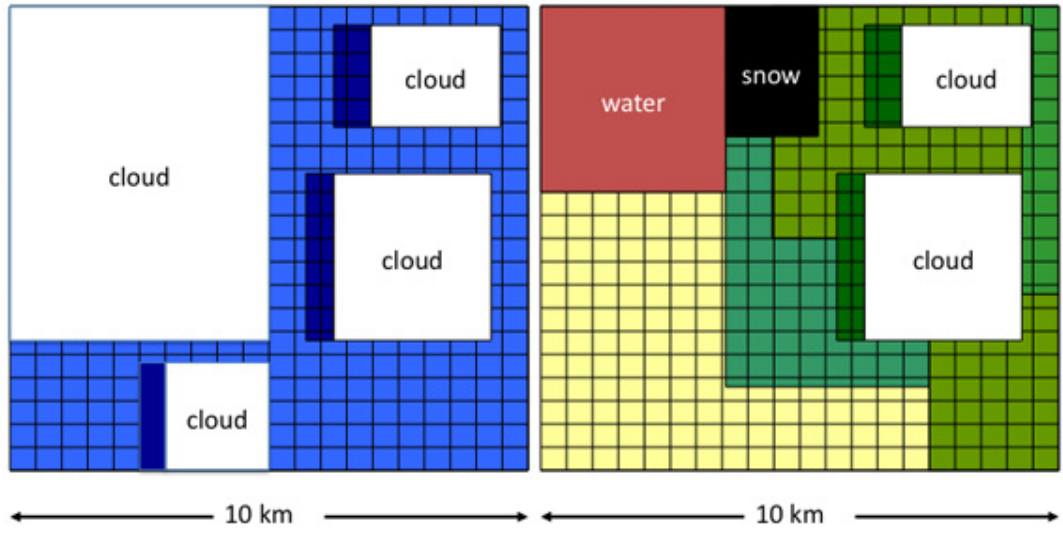
Fig. 4. Schematic of a MODIS aerosol algorithm nominal 10km retrieval box over ocean, left, and land, right. In any given 10km box there could be both cloudy and cloud-free pixels identified, and over land a variety of surface features as well. Starting from 400 pixels at 0.5km resolution, represented by the small grid squares, 225 are identified as cloudy over ocean and 55 over land. The land algorithm also eliminates an additional 196 pixels due to inappropriate surface features. This leaves 175 “good” pixels over ocean and 149 over land. From these the darkest and brightest pixels are arbitrarily eliminated, as described in the text, leaving 87 pixels from which to derive aerosol in the ocean 10km box and 44 pixels in the land box. Table 1. The four cloud masks mentioned in this study. Only the MODIS aerosol and GOES-R cloud masks undergo